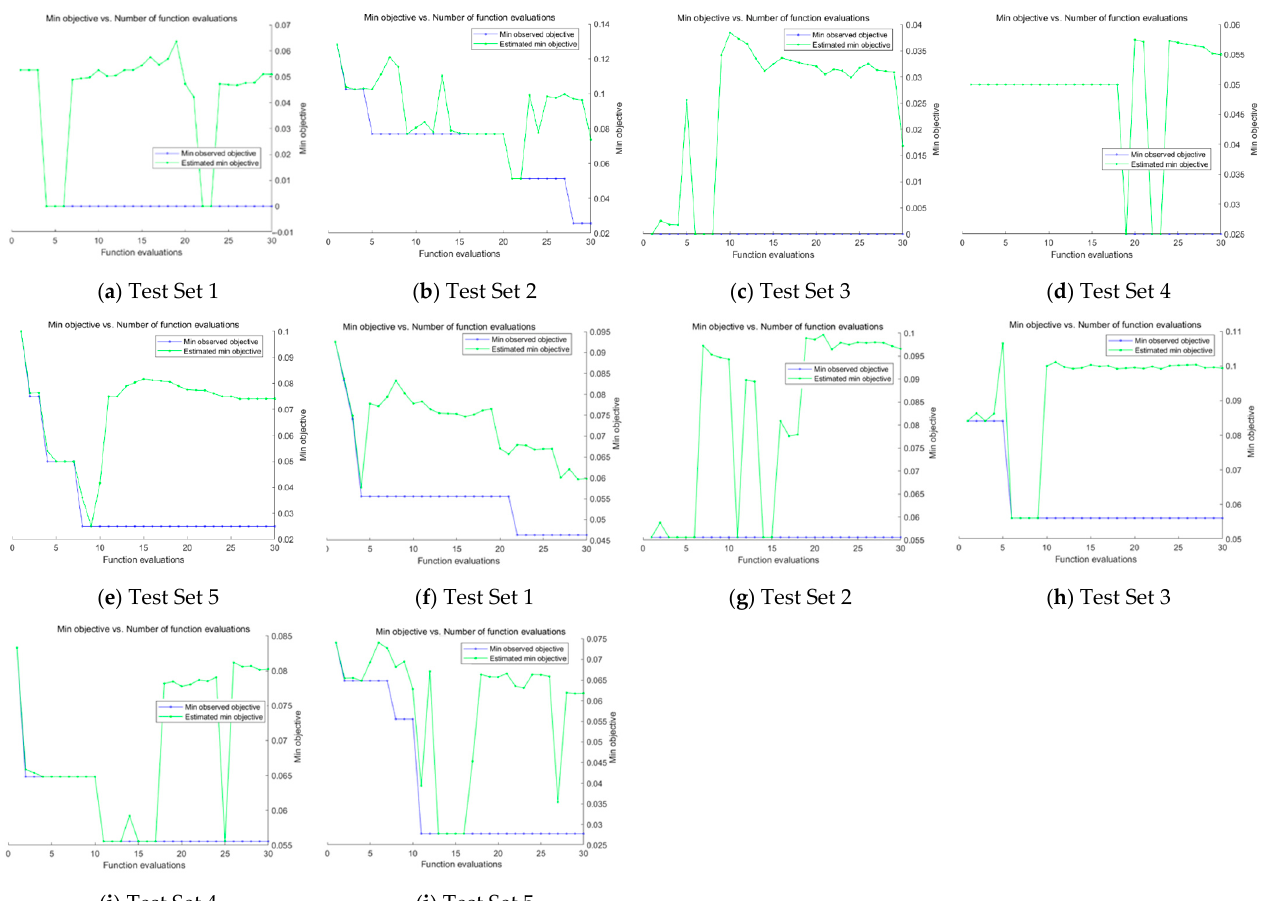
Figure 12. Bayesian Optimization process on Test Sets by CSGBBNet. ( a – e ): The results on the COVID Academic dataset. ( f – j ): The results on the COVID-CT dataset.